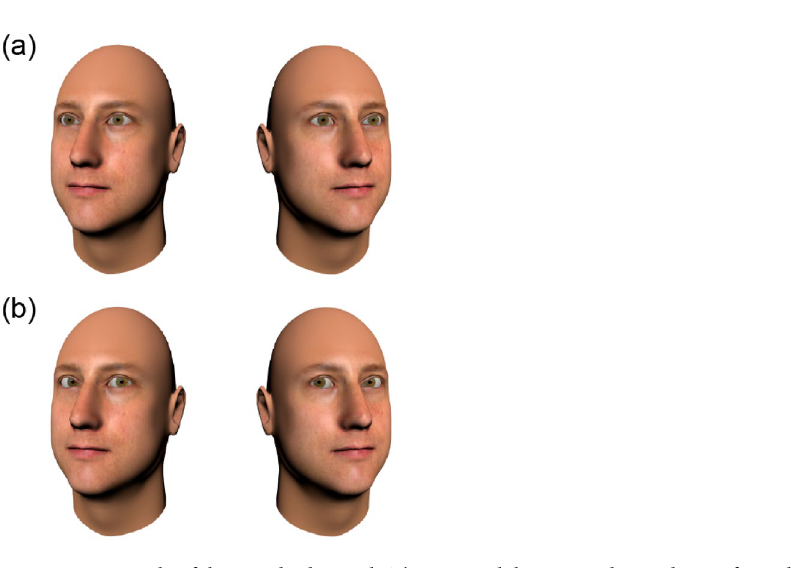
stimulus at a time and were required to report whether they perceived the gaze direction as left, direct, or right. Stimuli were presented for 1 s in each trial, and participants completed 24 trials of each head/eye combination. The viewing distance, size and placement (2.2° to the left or right of fixation, presented randomly across trials but balanced across eye deviations) of stimuli were the same as that used in the subsequent CFS experiment 34 . On completion, data for each participant was visually inspected to find the angle of eye deviation associated with the cleanest pattern of direct percepts for incongruent head/eye combinations and averted percepts for congru- ent head/eye combinations. This eye deviation was then selected for that subject as the optimal gaze deviation and used to create their Wollaston stimuli for the CFS task. For example, if a participant’s optimal gaze direction was 8°, the deviations for the direct and averted Wollaston Stimuli was 8° or − 8°. Participants were precluded from performing the CFS task, if none of the tested eye deviations produced a consistent perceptual distinction between the congruent and incongruent head/eye combinations.